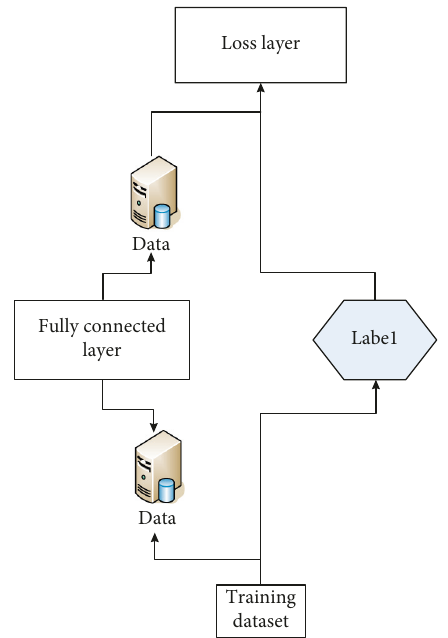
Figure 4: Logistic regression network